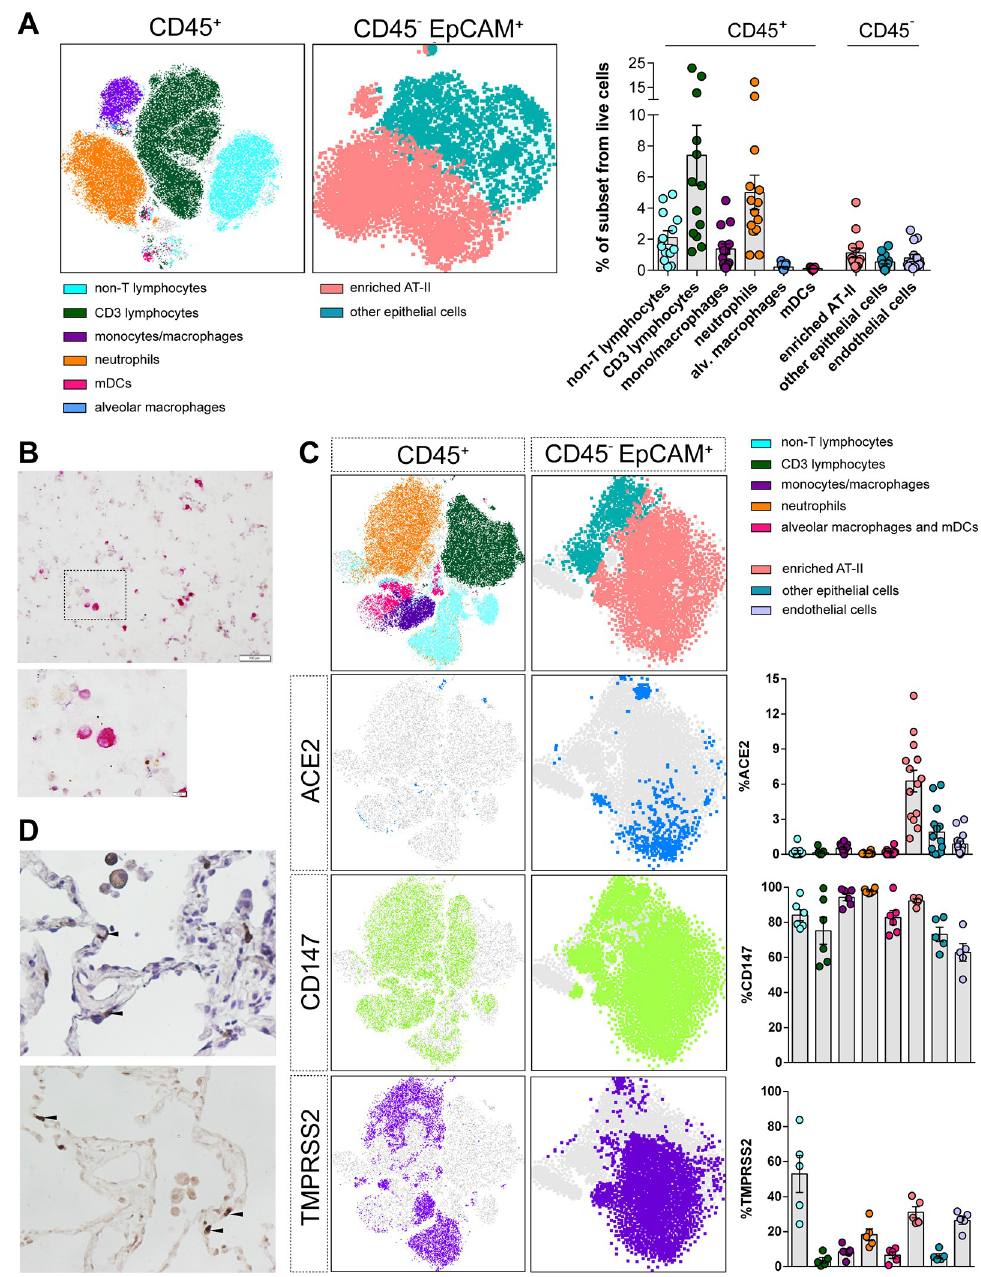
Fig 1. Phenotyping of human lung cells. ( A ). t -distributed Stochastic Neighbor Embedding (t-SNE) representation displaying the major cell clusters present in the CD45 + and CD45 - EpCAM + fractions of a representative human lung tissue. The vertical bars in the right panel show the frequency of each subset relative to live cells. All cell subsets were identified as shown in S2A Fig. mDCs, myeloid dendritic cells; enriched AT-II, enriched fraction in alveolar type 2. ( B ). Phosphatase alkaline positive AT-II cells (pink staining) were detected in a cytospin obtained from human lung tissue cells and observed at 10x. Lower panel shows a high magnification (40x) of the black square. Scale bars are 100 μ m and 10 μ m in top and bottom panels, respectively. ( C ). t -distributed Stochastic Neighbor Embedding (tSNE) representation for ACE2, CD147 and TMPRSS2 expression in CD45 + and CD45 - EpCAM + fractions from a representative lung tissue. Right graphs show the percentage of expression of each entry factor in the different cell subpopulations, which were identified as in Fig 1A with some modifications for the identification of myeloid cells and neutrophils (From big cells: monocytes/macrophages, CD11c + HLA-DR + CD14 + ; Alveolar macrophages and mDCs, CD11c + HLA-DR + CD14 - ; Neutrophils, CD11c - HLA-DR - CD14 - CD3 - ). ( D ). Images of ACE2 immunohistochemical staining in human lung tissue sections at 40x magnification, counterstained with haematoxylin (top) or without (bottom). Black arrows indicate staining of ACE2 in AT-II cells (upper panel). Mean ± SEM is shown for all graphs. https://doi.org/10.1371/journal.ppat.1010171.g001 PLOS Pathogens| https://doi.org/10.1371/journal.ppat.1010171 January13,